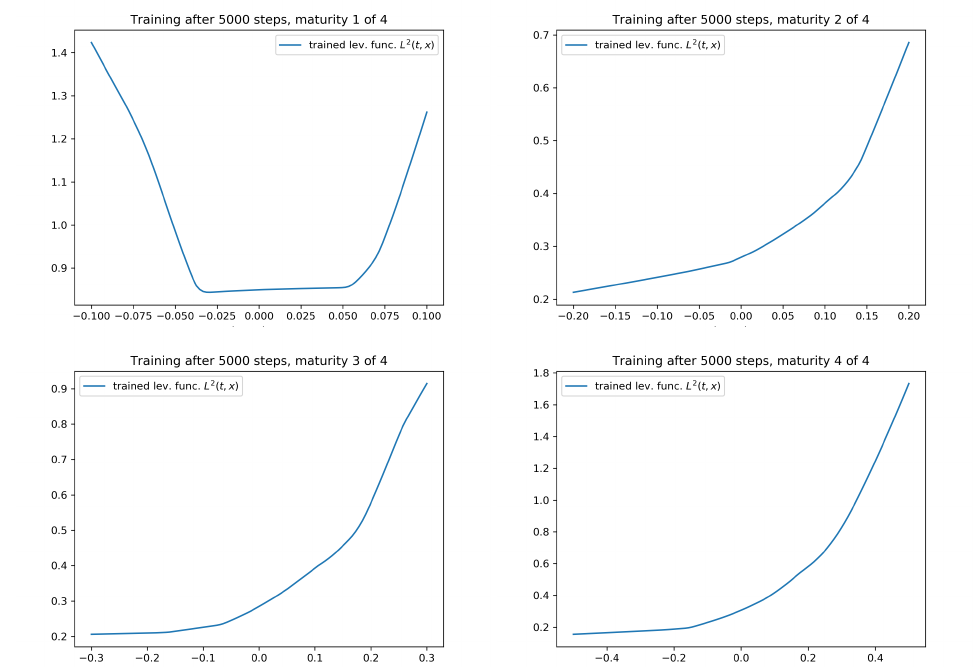
Figure 4. Plot of the calibrated leverage function x (cid:55)→ L 2 ( t , x ) at t ∈ { 0, T 1 , T 2 , T 3 } in the example shown in Figure 3. The x -axis is given in log-moneyness ln ( K / S 0 )